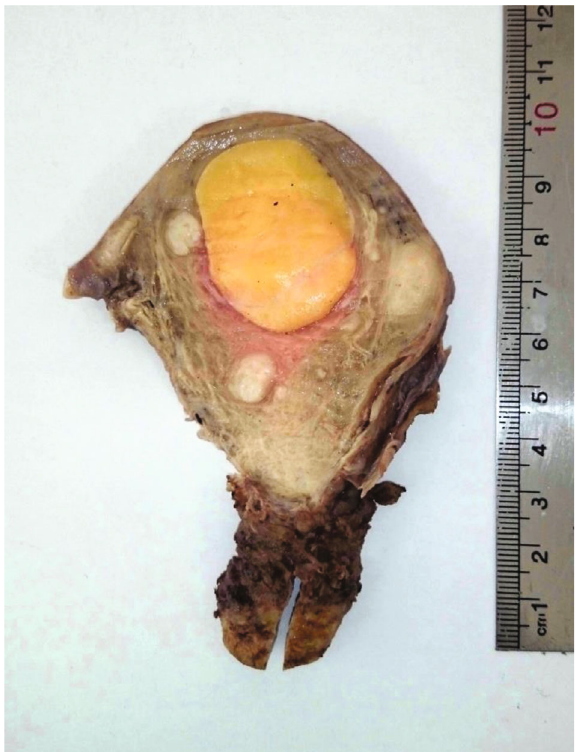
Figure 1: Cut section of the uterus showing an intramural well- de fi ned bright yellow homogenous mass.